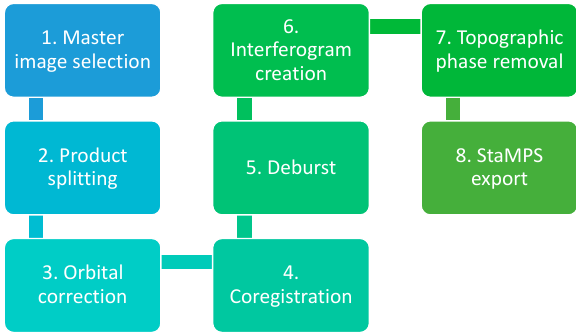
Figure 5. Work fl ow of the InSAR processing. Figure 5. Workflow of the InSAR processing.